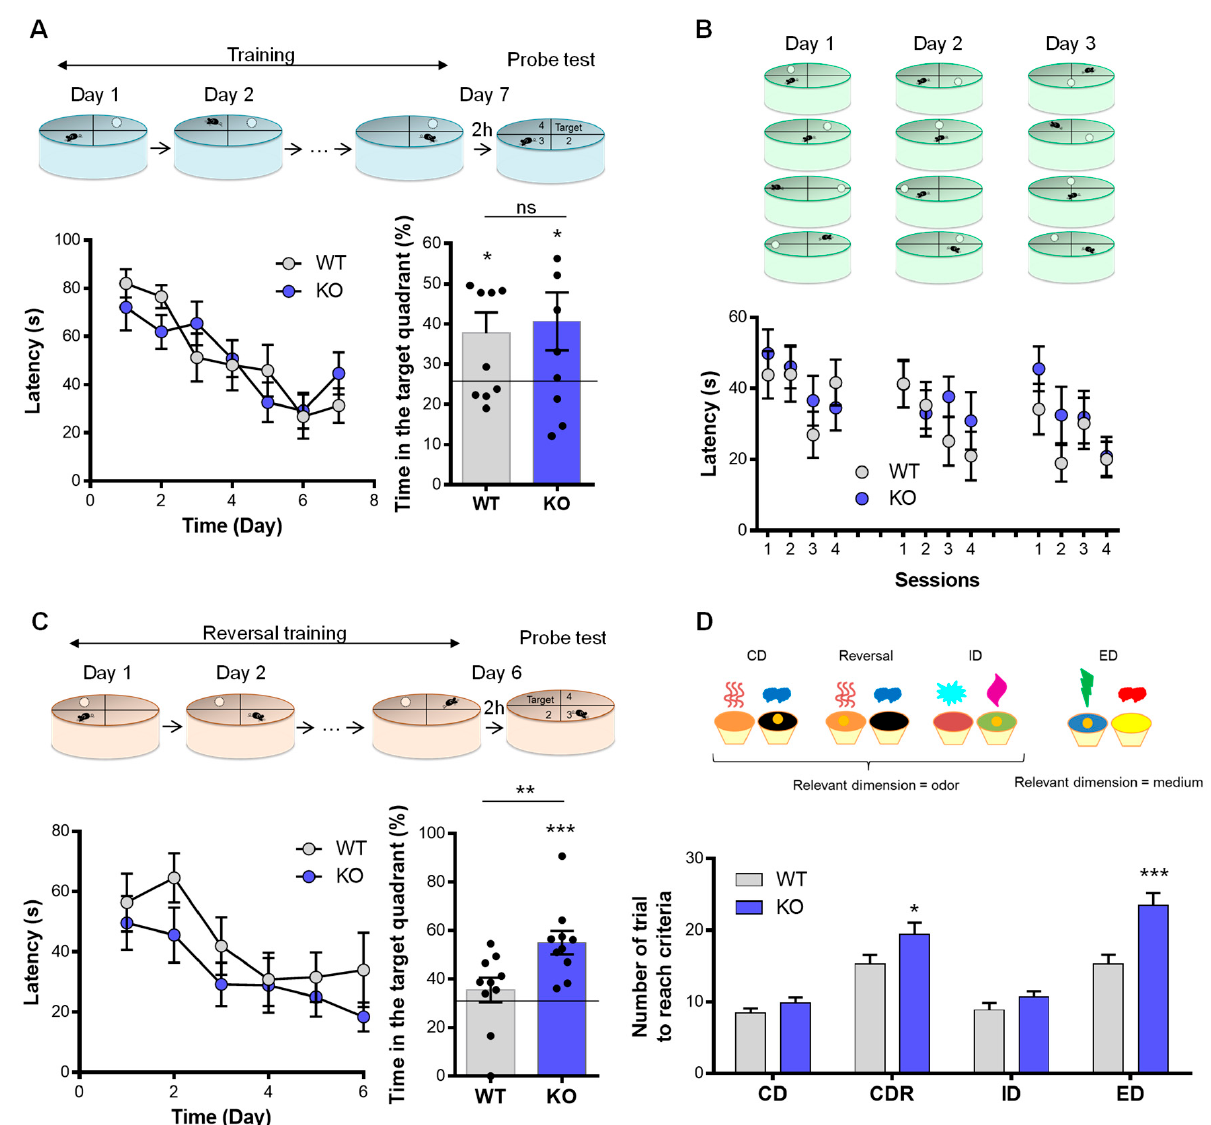
Figure 3. Learning, memory, and adaptative behavior in VMAT2 DBHcre mice. ( A ) Mean escape latency (s) in the spatial hidden-platform version of the Morris water maze in VMAT2 DBHcre WT and KO (n = 10 per group, left) (genotype: F (1,18) = 0.012, p = 0.91; session: F (6,108) = 10.86, p < 0.001; genotype ×